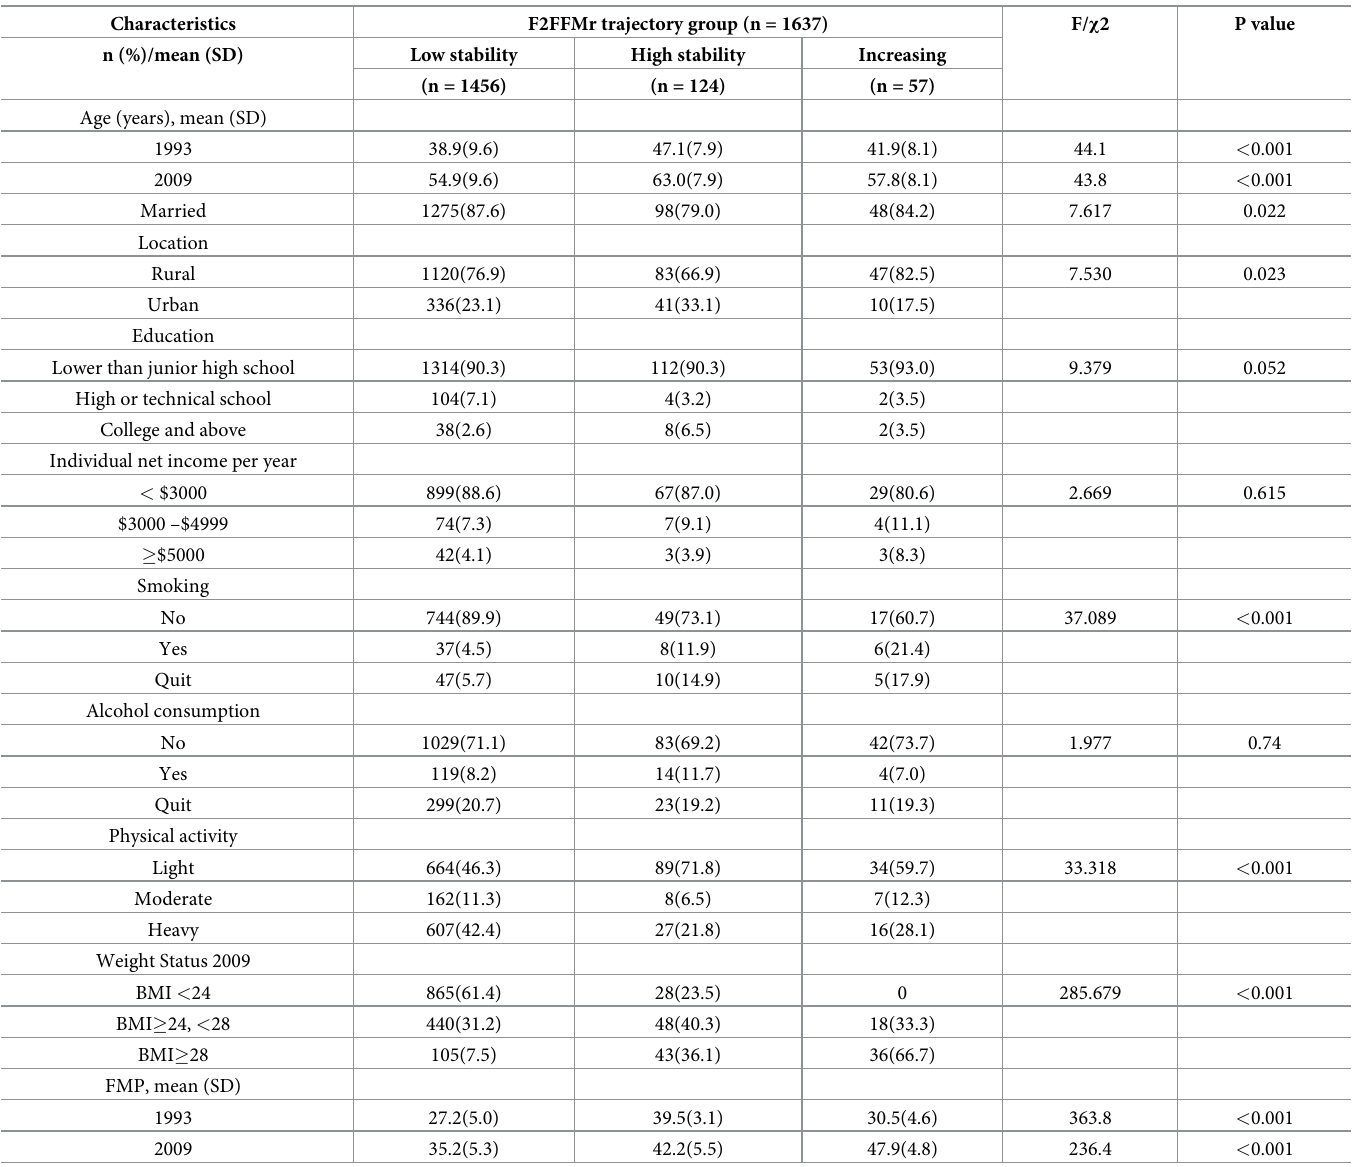
Table 3. Characteristics of the female participants, according to their latent F2FFMR trajectory